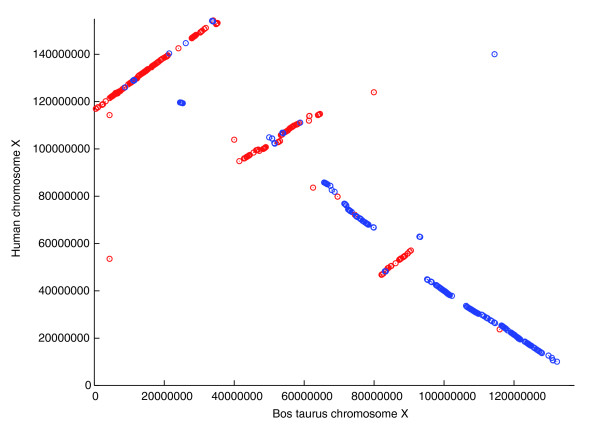
Aligment of B. taurus chromosome X to human chromosome X, showing regions of large-scale synteny. Most of the two chromosomes is shared in the five large blocks evident in the figure. Red: sequences are aligned in the same orientation; blue: sequences are aligned, but one is in the reverse complement orientation. The inverted (blue) block at approximately 25 Mbp in B. taurus, although small at this scale, spans over 800 Kbp.